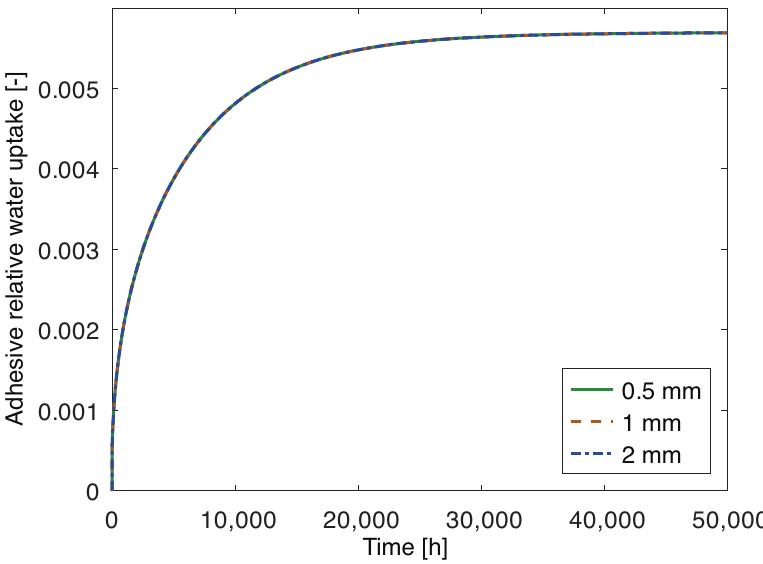
Figure 10. Numerical water uptake only through the adhesive layer of joints with 2 mm thick aluminum substrates and 0.5 mm, 1 mm, and 2 mm thick